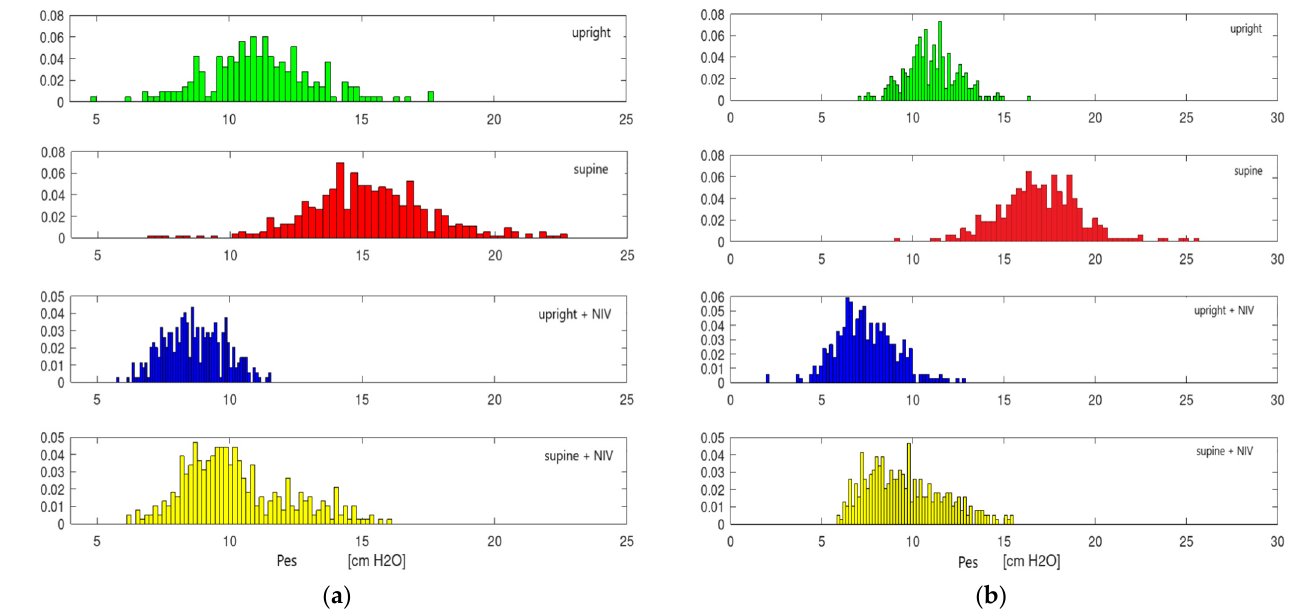
Figure 3. Variation of ∆ Pes at D1 ( a ) and D3 ( b ) depends on the position and presence of NIV. Normal data distribution can be observed.